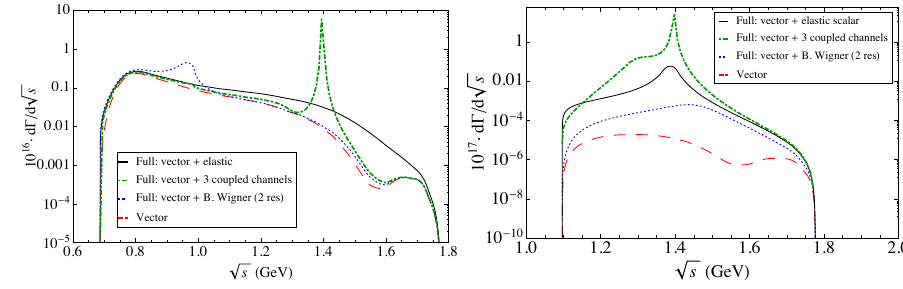
Figure 4. Decay spectrum for τ − → π − ην τ (left) and τ − → π − η (cid:48) ν τ (right). See Ref.[4] for